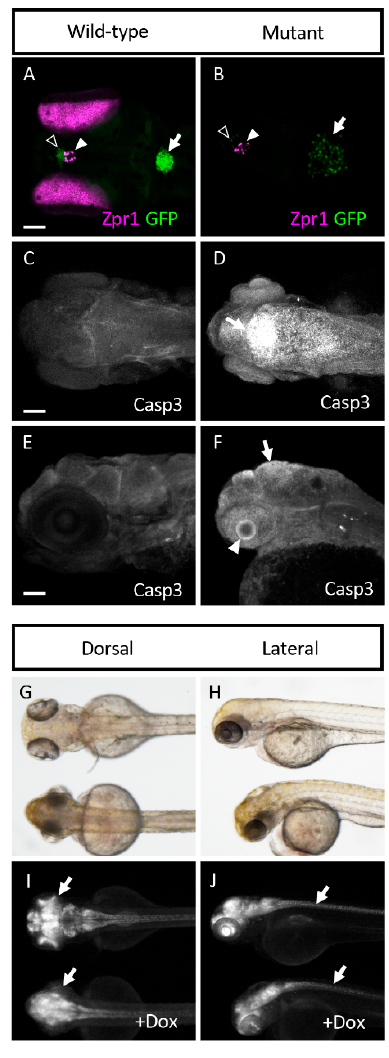
Figure 6. cp27.5 mutants express Zpr1 in the pineal gland, activated Caspase 3 in brain ventricle and eyes, and HuC in brain and spinal cord. ( A ) Wild-type cp27.5 larvae at 4 dpf with GFP (green) in the dCP (open arrowhead), and mCP (arrow) and Zpr1 expression (purple) in the pineal gland (filled arrowhead) and eyes. ( B ) Mutant cp27.5 larvae at 4 dpf with GFP (green) in the dCP (open arrowhead), and mCP (arrow) and Zpr1 expression (purple) in the pineal gland (filled arrowhead). Mutants have no Zpr1 expression in the eye. dCP, diencephalic choroid plexus; mCP, myelencephalic choroid plexus. ( C , D ) Dorsal confocal image with activated Caspase 3 antibody reveals expression in the dorsal midline in cp27.5 mutants, but not in cp27.5 wild-type. ( E , F ) Lateral confocal image with activated Caspase 3 antibody reveals expression on the brain ventricle surface (arrow) and eye (arrowhead) in cp27.5 mutants, but not in cp27.5 wild-type. cp27.5 larvae treated with doxycycline induces the TetON system using the HuC promoter resulting in GFP expression throughout the CNS. ( G , H ) Brightfield DIC images show wild-type larvae (top) and mutant larvae (bottom). ( I ) Wild-type larvae (top) treated with doxycycline express GFP eyes, while mutant larvae have no GFP expression in the eyes (arrows). ( J ) Wild-type larvae (top) and mutant larvae (bottom) treated with doxycycline both have GFP expression in the spinal cord (arrows). Scale bars are 50 µm.